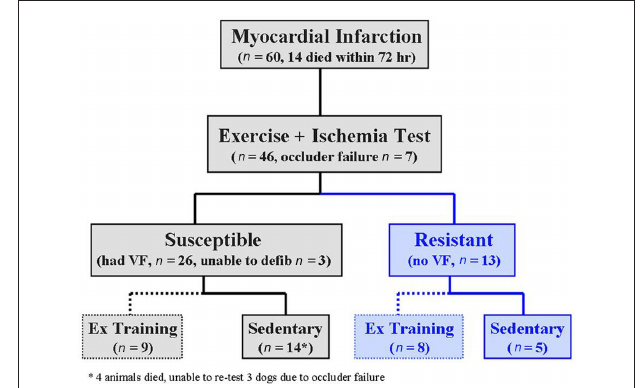
Figure 1 | Flow chart illustrating the sequences of events in this study. Three to 4 weeks after myocardial infarction, the dogs were classified as susceptible (black) or resistant (blue) to ventricular fibrillation (VF) with an exercise plus ischemia test. The animals were then randomly assigned to either 10-week exercise (Ex) training program (dashed lines) or a 10-week sedentary period (solid lines). The exercise plus ischemia test was repeated at the end of the 10-week period. n = number of animals; defib =